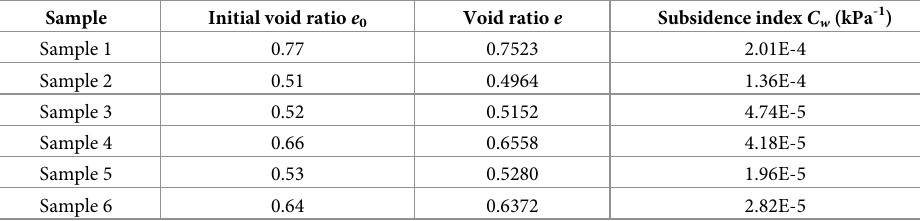
Table 8. Subsidence index C w of each soil sample.